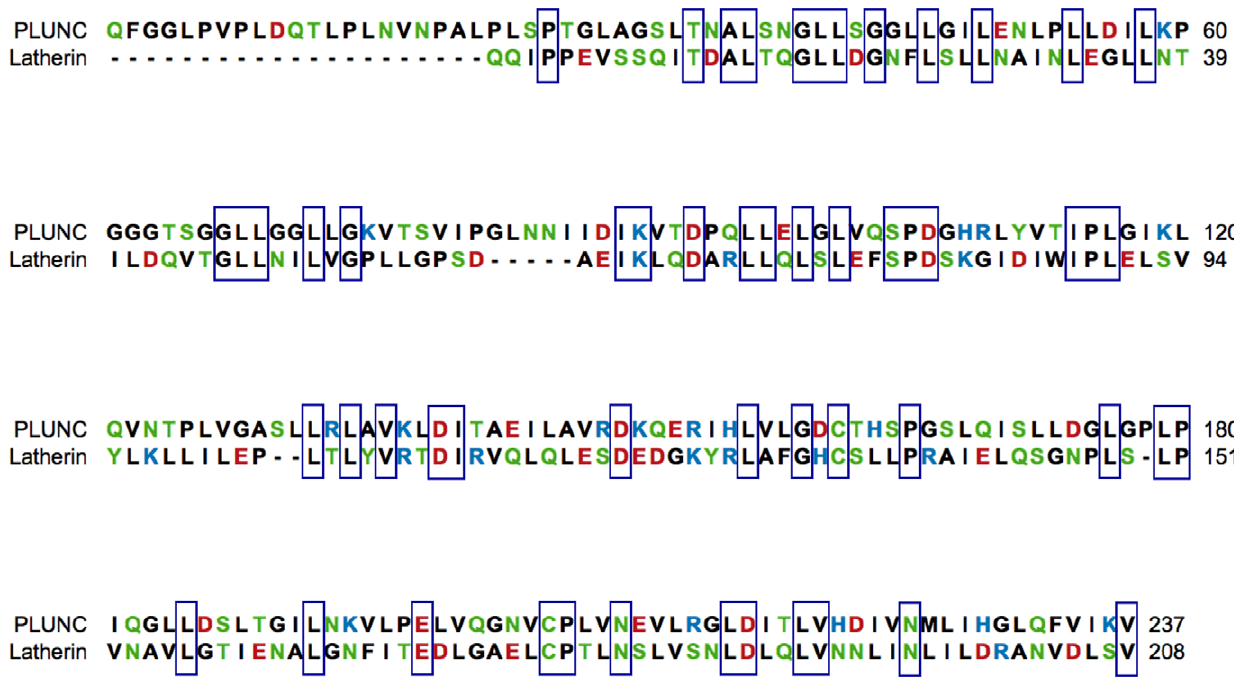
Figure 1. Multiple sequence alignment of PLUNC and latherin. Alignment depicts the amino acid sequence of human PLUNC (NP_057667), aligned with horse latherin (NP_001075328). The mature form of PLUNC was predicted using the SignalP 3.0 server (http://www.cbs.dtu.dk/services/ SignalP/) to identify the likely location of the signal sequence [56]. Hydrophobic residues are shown in black, hydrophilic residues are green, basic residues are blue, and acidic residues are red. Blue boxes indicate conserved residues. Alignment was constructed using the CLC Bio Workbench 4.1.1 (CLC Bio A/S, Aarhus, Denmark).